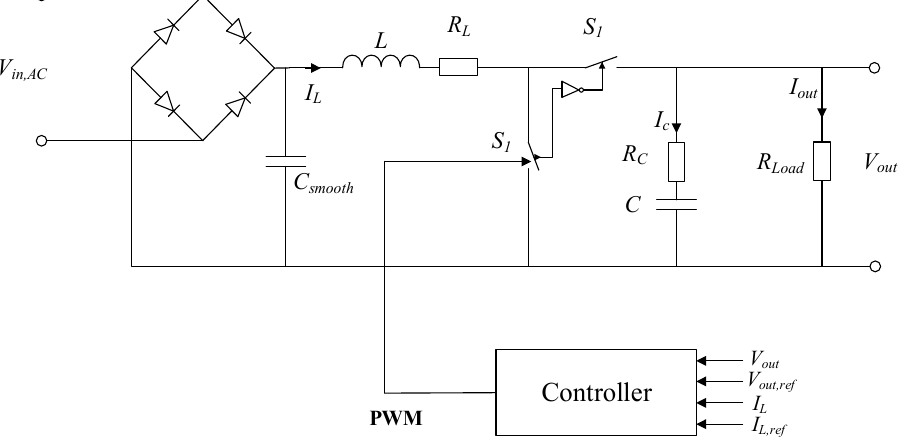
Figure 3. Boost PFC to be identified.